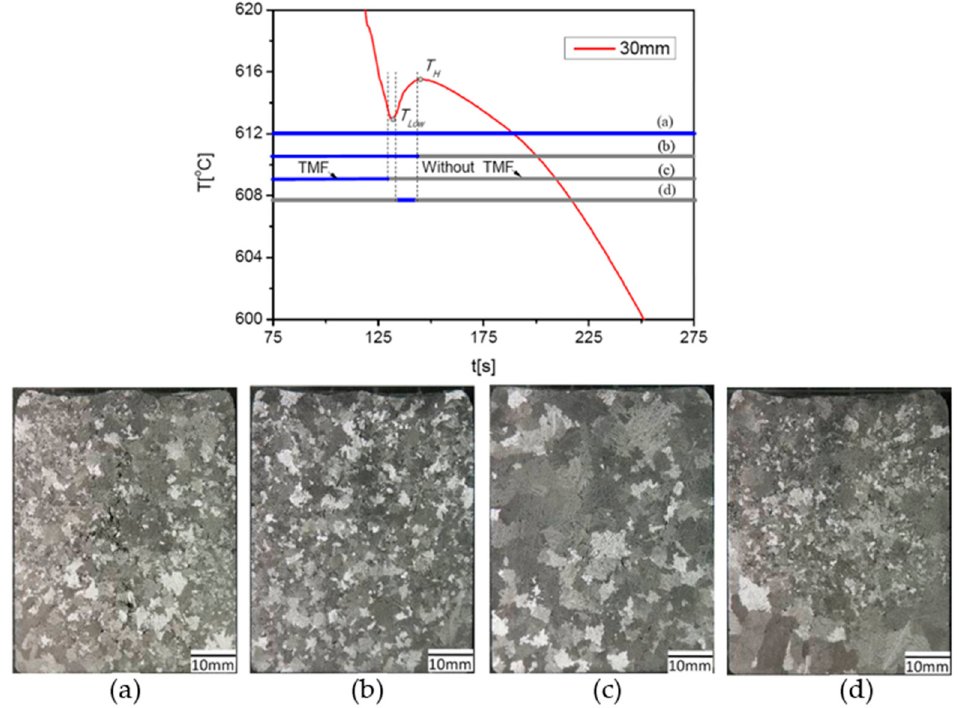
Figure 6. Influence of the various TMF (10 mT, downward) application time on the longitudinal section macrostructure of the solidified Al ‐ 7 wt. %Si alloy: ( a – d ) correspond to the various application times shown in the schematic view (blue line: turn on TMF; grey line: turn off TMF).